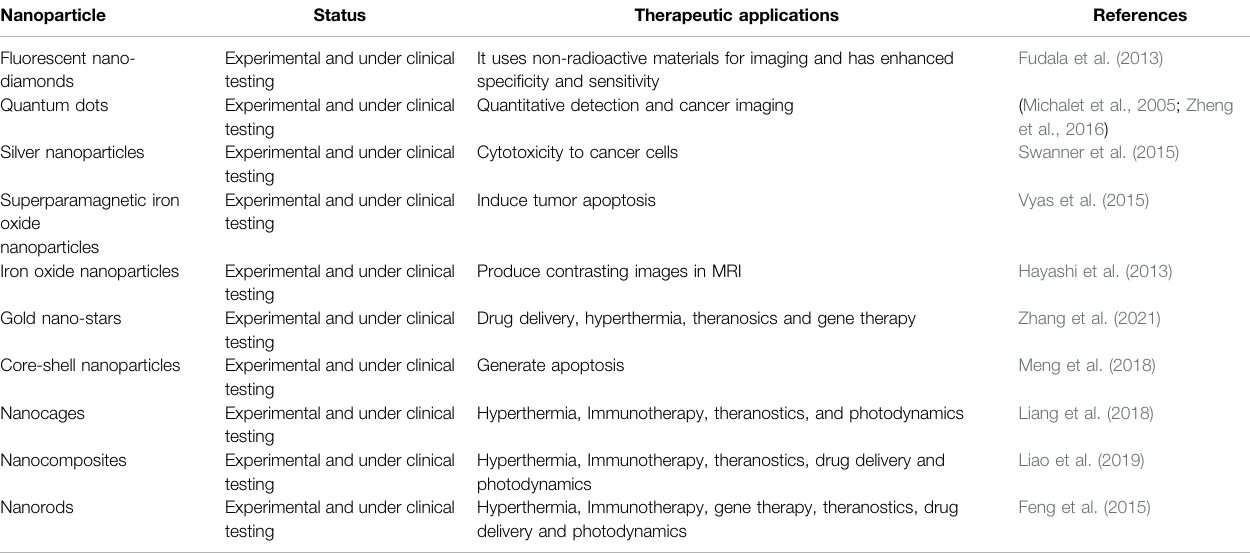
TABLE 2 | Different types of nano medicines under experimental and clinical testing for TNBC theranostics (Medina et al., 2020).